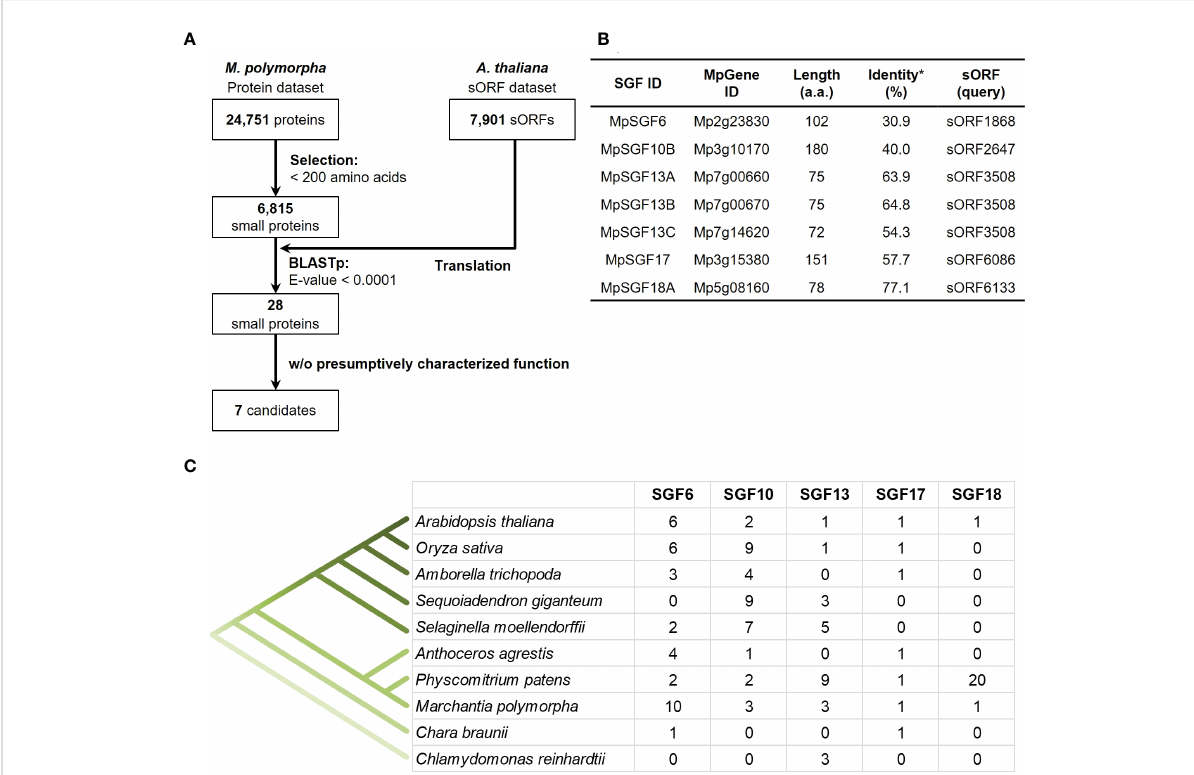
FIGURE 1 Selection of candidates for M. polymorpha peptide-coding genes. (A) A pipeline for the selection of peptide candidates. The A. thaliana sORF dataset is used as a query for BLASTp analysis. (B) A list of selected peptide candidates in M. polymorpha . *Percentages of identity between MpSGFs and corresponding sORFs in A. thaliana are shown. (C) The number of orthologs of SGFs in land plants. Orthologous genes with the same gene family ID (ORTHO05DXXXXXX) to Mp SGF s were obtained from Dicots PLAZA 5.0 (Bel et al., 2021; https://bioinformatics.psb.ugent. be/plaza/versions/plaza_v5_dicots/). For A. thaliana , sORF genes without AGI codes were included. For M. polymorpha , only genes in the latest database, MpTak v6.1, are shown. See Supplementary Table S3 for more